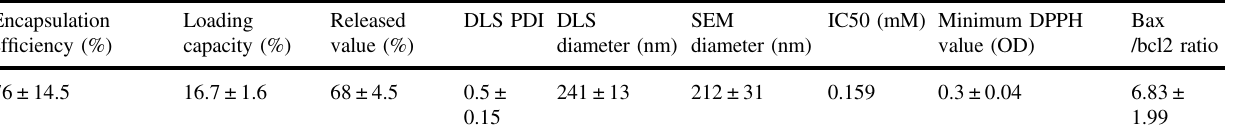
Table 4 All physicochemical properties of the curcumin niosome nanoparticles Encapsulation ef fi ciency